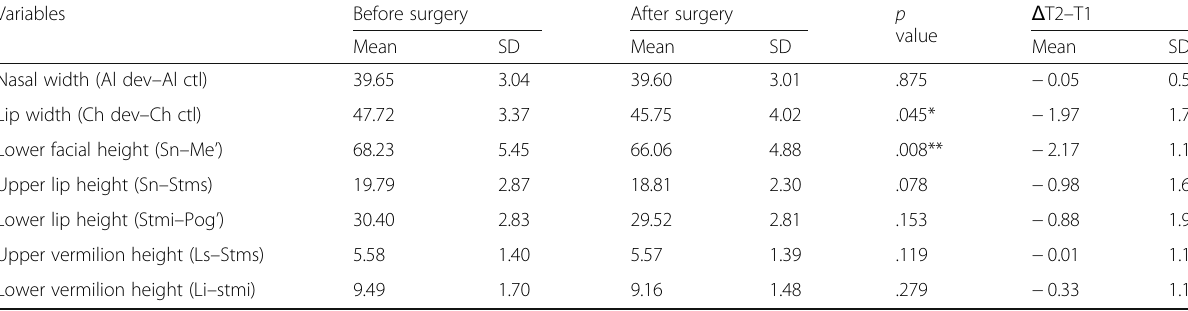
Table 5 Linear changes in soft tissue measurements after mandibular setback surgery Variables Before surgery After